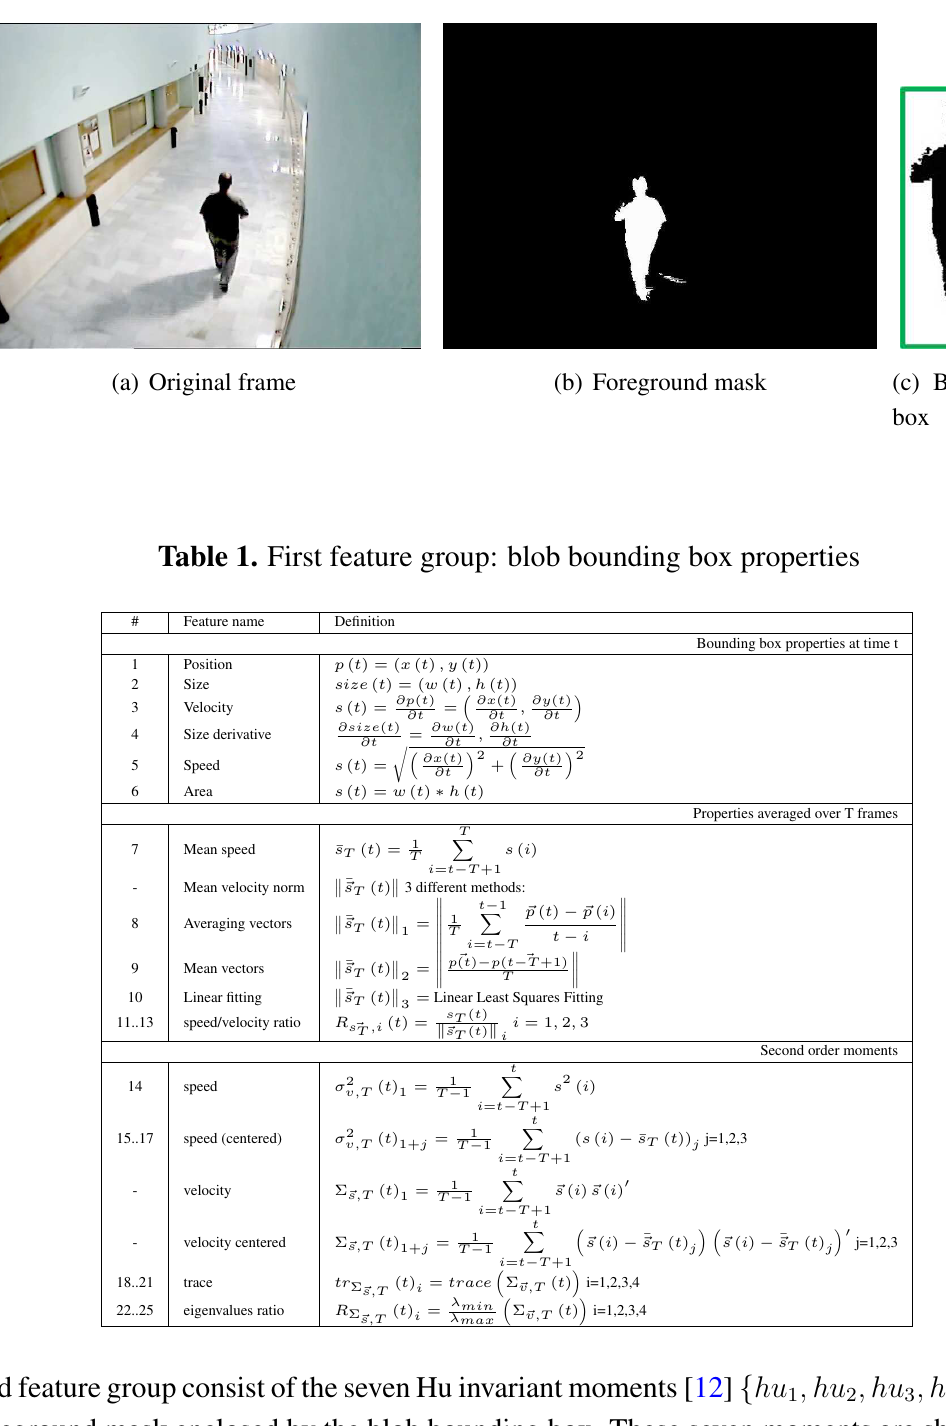
Figure 3. Inputs for the feature extraction process